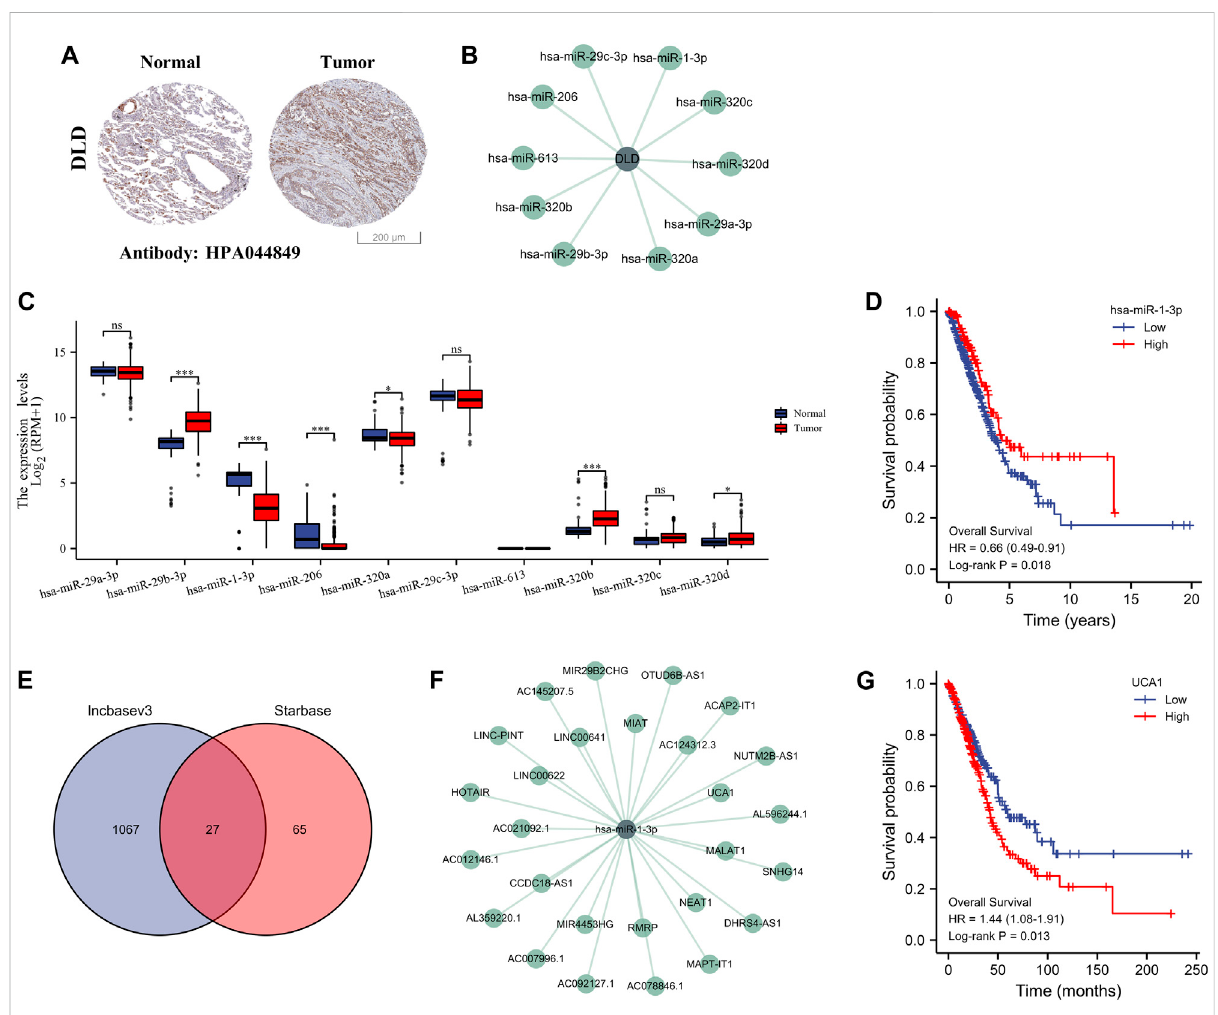
FIGURE 9 Construction of the ceRNA regulatory axis. (A) Differential expression of DLD protein in LUAD and normal lung tissues (HPA). (B) Ten miRNAs associated with DLD. (C) Differential expression of the 10 miRNAs in LUAD and normal lung tissues. ns, p ≥ 0.05; *, p < 0.05; ***, p < 0.001. (D) OS curvesofDLDinpatientswithLUADinthelowandhighexpressiongroups. (E) Identi fi cationof20lncRNAsbytheStarbaseandlncbasev3databases. (F) The 27 miRNAs associated with miR-1-3p. (G) OS curves of UCA1 in patients with LUAD in the low and high expression